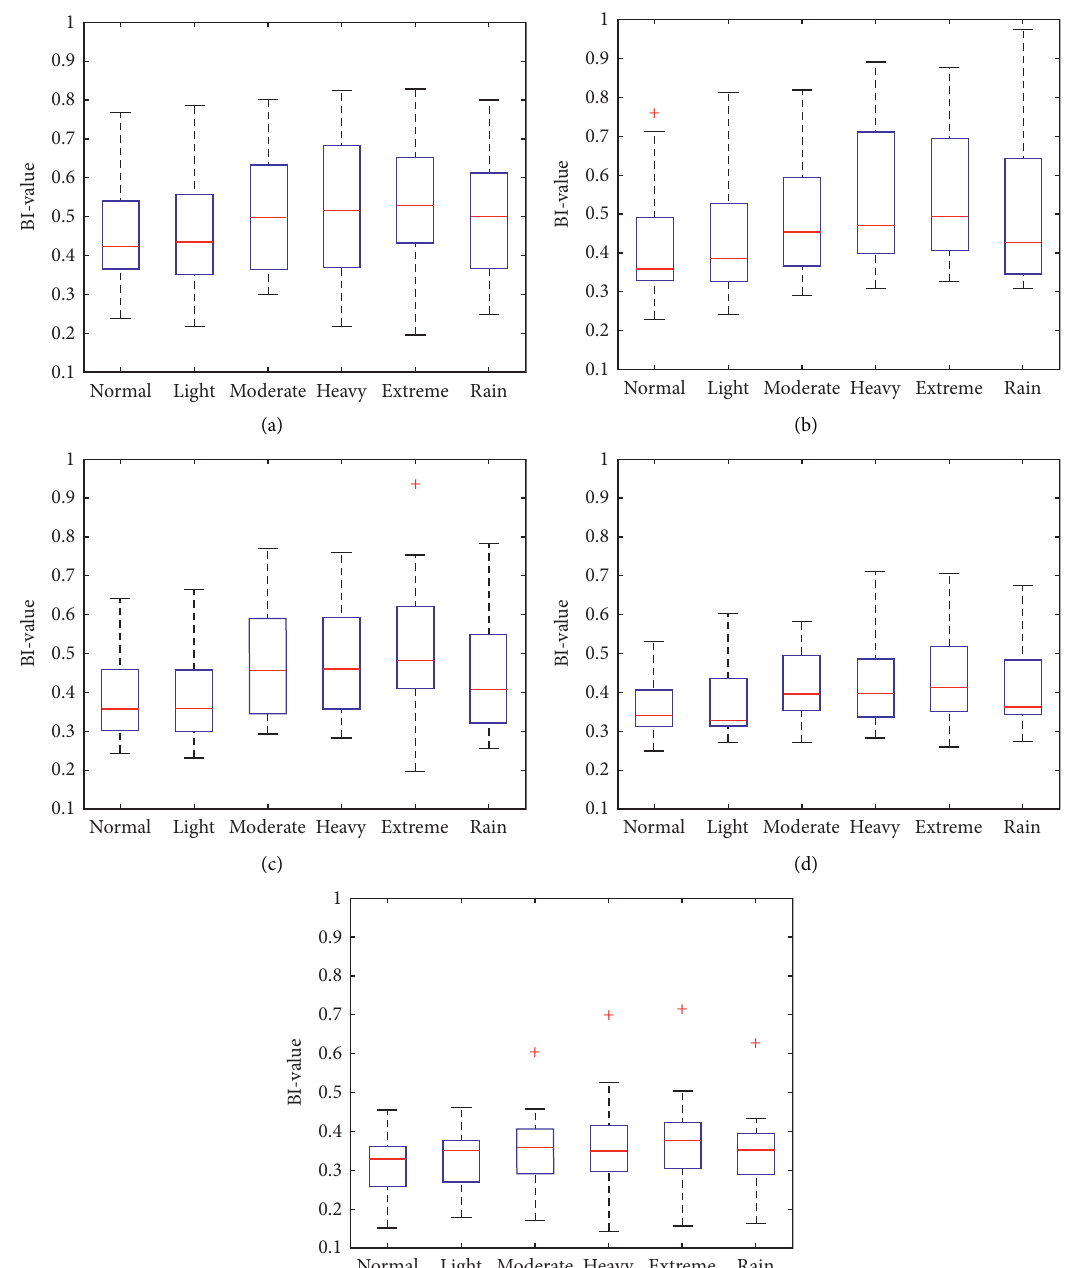
Figure 4: BI-value boxplots under six conditions within five travel time ranges. (a) Average O-D-based travel times within 0–5 mins. (b) Average O-D-based travel times within 5–10mins. (c) Average O-D-based travel times within 10–15mins. (d) Average O-D-based travel times within 15–20mins. (e) Average O-D-based travel times within